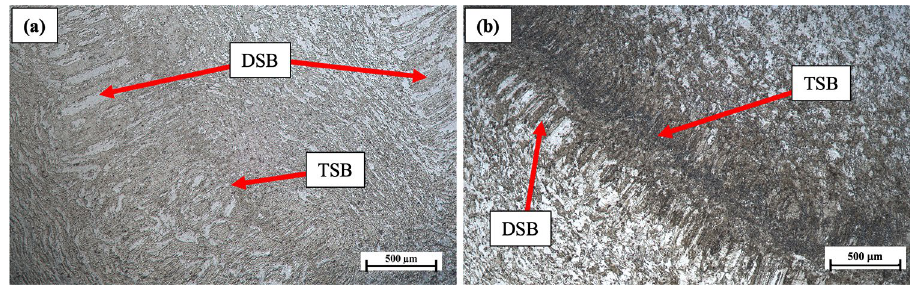
Fig. 13 OM images of the ASBs in specimens deformed at 300 °C with ( a ) 5000 s −1 up to ~ 0.50 strain and ( b ) 4300 s −1 up to ~ 0.57